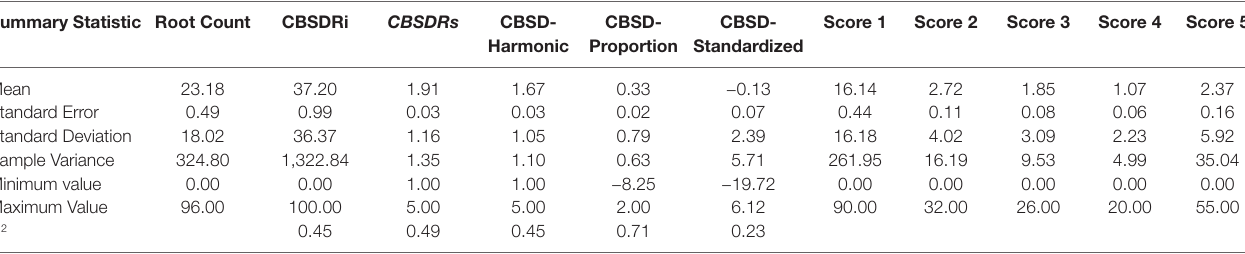
TABle 1 | Summary statistics and CBSD root necrosis scale and assessment methods. Summary Statistic Root